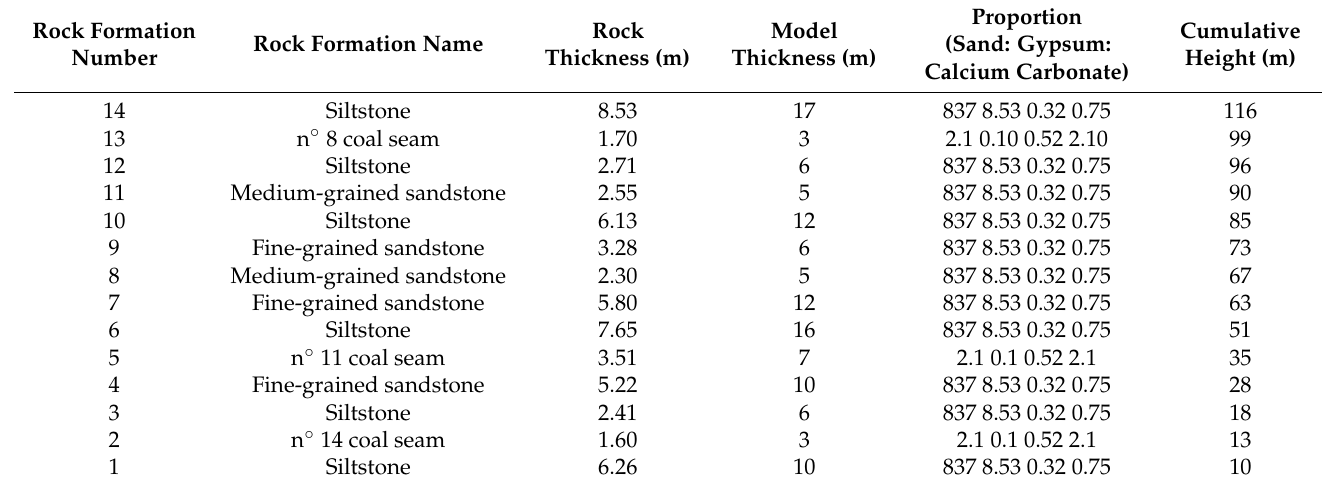
Table 2. Physically similar simulated material